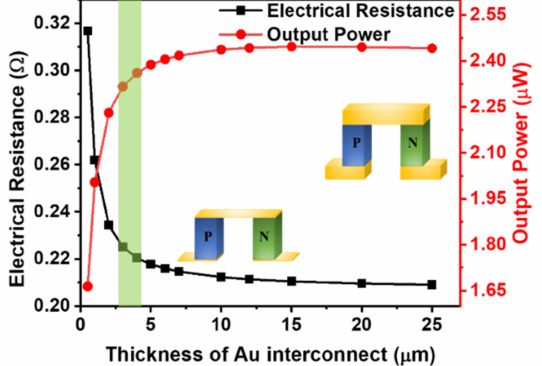
Figure 5. Electrical resistance and output power as a function of interconnect material thickness at 5 K temperature